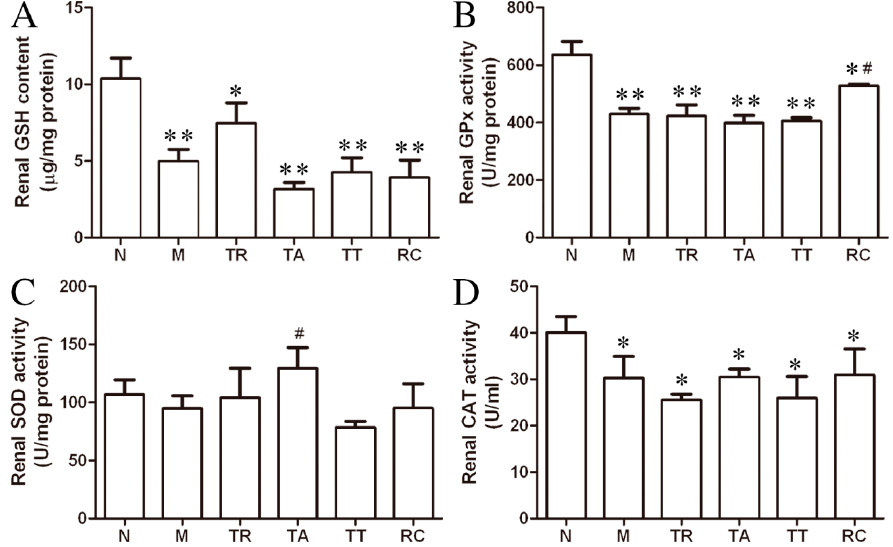
Figure 4. At 48 h after HgCl 2 administration, there were almost no significant variation observed in superoxide dismutase (SOD) activity, renal catalase (CAT) activity, and renal glutathione (GSH) content of each rhubarb extract group except the remaining components group (RC) for GPx and the total anthraquinones (TA) for SOD activity reversing ( p < 0.05). ( A ) The level of renal cellular GSH; ( B ) the activity of renal GPx; ( C ) the activity of renal SOD and ( D ) the activity of renal CAT. The data were presented as means + SE of eight rats in each group. * p < 0.05, ** p < 0.01 vs. group N; # p < 0.05 vs. group